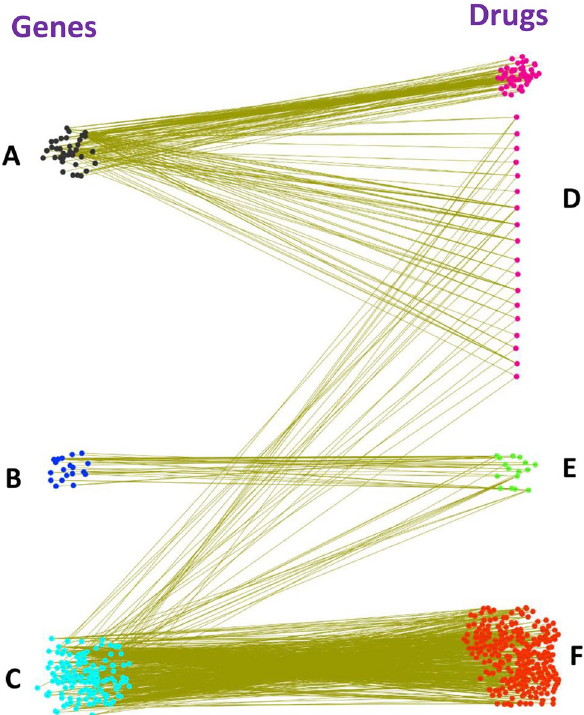
Figure 8. Robustness of gene ranking. ( A – C ) Gene ranking of total 202 targets of at least one of the 380 drugs (Supplementary Table S2). ( A ) Top 37 genes lie on the lower circled portion (mean FCG < 10 ( B ) 19 Genes lie in between the lower and upper circled portion (mean FCG lies between 10 Fig. 1. ( C ) Bottom 146 genes lie on the upper circled portion (mean FCG > 0.99995 ) in Fig. 1. ( D ) 73 drugs − 6 (mean FCG < 10 ) significantly reduce the growth rate of cancer models. ( E ) 16 drugs which gives mean FCG − 6 between 10 to 0.99995 in cancer models. ( F ) 291 drugs that show no effect (mean FCG > 0.99995 ) in the cancer